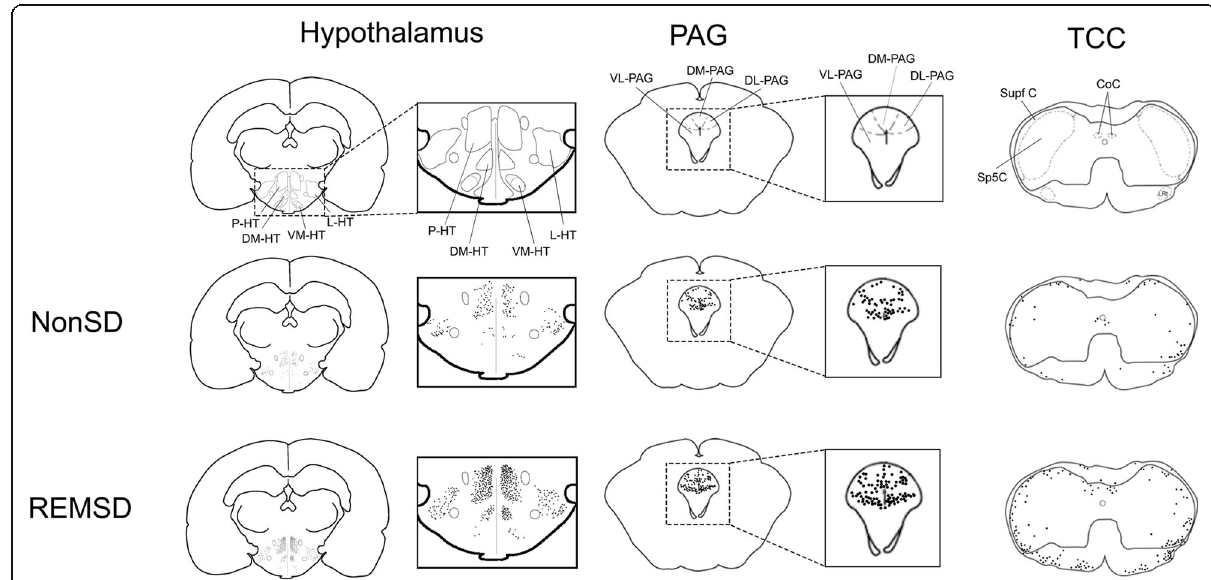
Fig. 2 Visual comparisons of the distributions of c-Fos-positive cells in the hypothalamus, PAG, and TCC in each group after REM sleep deprivation. The number of C-Fos-positive cells was significantly higher in the P-HT, DM-HT, VL-PAG, and Supf C. Abbreviations: PAG: periaqueductal gray; TCC: trigeminal nucleus caudalis; P-HT: posterior hypothalamus; DM-HT: dorsomedial hypothalamus; VL-PAG: ventrolateral PAG; Supf C: superficial layer